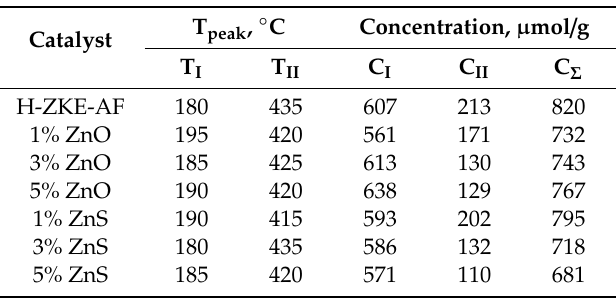
Figure 3. Thermal desorption spectrum of ammonia on H-ZKE-AF modified by 1–5% zinc oxide: (1) pure H-ZKE-AF, (2) 1% ZnO additive, (3) 3% ZnO additive, (4) 5% ZnO additive. Table 3. Acid properties of catalysts with various additives of zinc sulphide and oxide according to thermal desorption spectra of NH 3